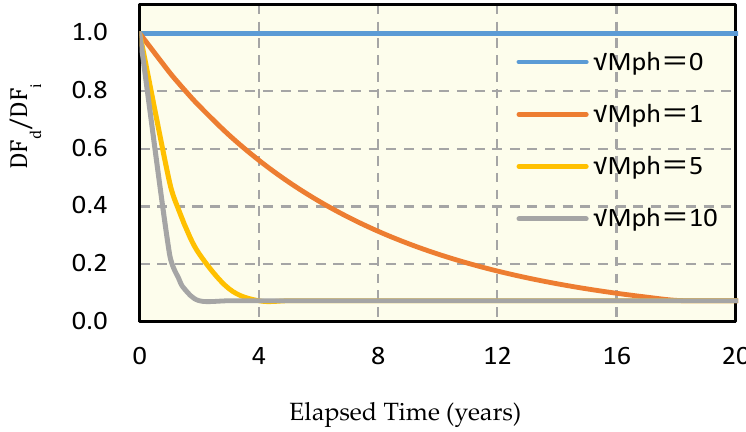
Figure 7. Degradation of durability factor for di ff erent modified maturities.